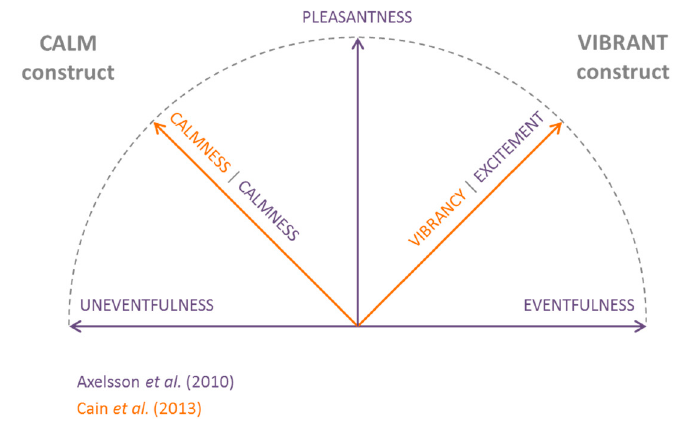
Figure 1. Schematic representation of the models for soundscape characterisation. Figure adapted from Axelsson et al. [30] and Cain et al. [31].